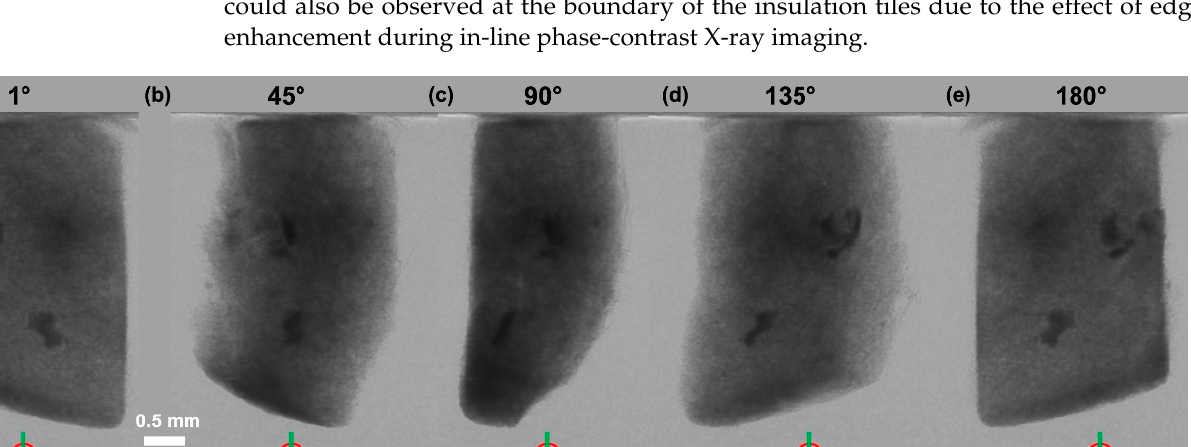
Figure 2. (a) Optical and (b, c) SEM images of the yttria-stabilized ZrO 2 fiber insulation tile. Figure 2. ( a ) Optical and ( b , c ) SEM images of the yttria-stabilized ZrO 2 fiber insulation tile. Compared with optical microscopy and scanning electron microscopy, X-ray micros- Compared with optical microscopy and scanning electron microscopy, X-ray mi- croscopy can nondestructively realize three-dimensional structural analysis. Herein, for tomographic imaging, projection images from 0 ◦ to 180 ◦ at a 0.5 ◦ rotation interval were acquired at an X-ray energy of 35 KeV. The whole sample was imaged nondestructively at this energy, and the transmission rate was 30–50%. The resulting X-ray images were formed as a function of the transmission of the X-rays through the material. In the projections, the internal ultrastructure could be clearly observed (Figure 3). The dark dots represent the aggregates of zirconia fibers and silica binder, which could not be observed by optical microscopy or electron microscopy without destroying the samples. The aggregations